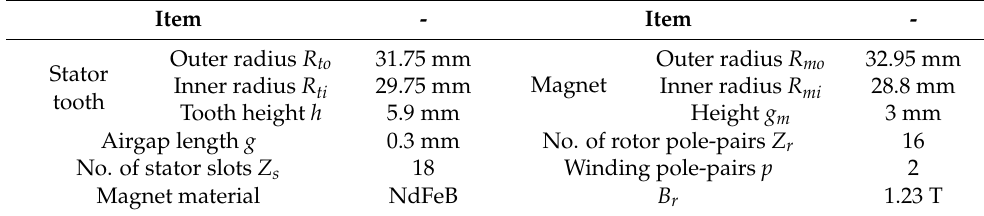
Figure 2. Top view of half proposed AFPMVM.